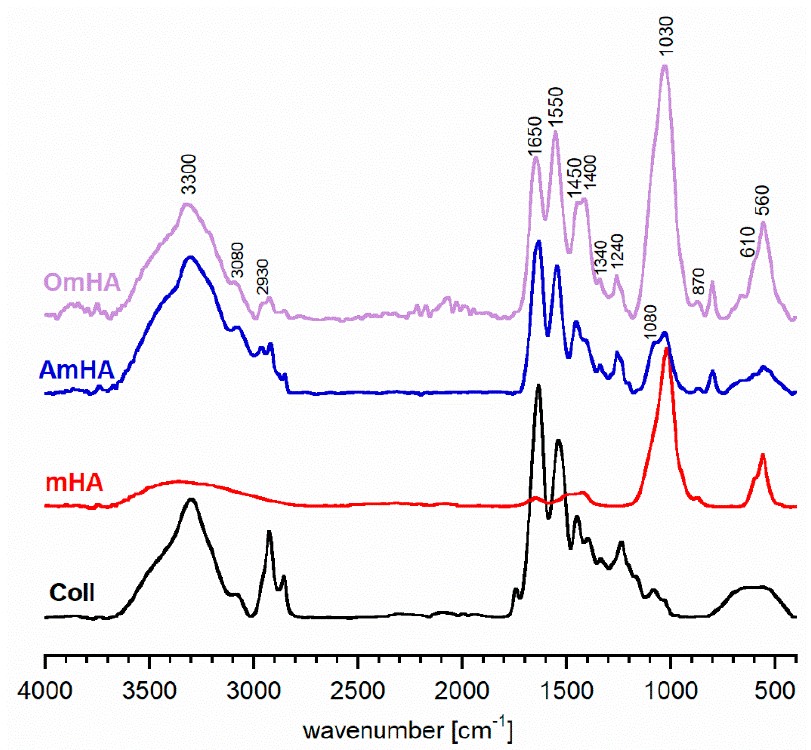
Figure 2. FT − IR spectra of the obtained composites (OmHA and AmHA), collagen type I (Coll), and hydroxyapatite (mHA).